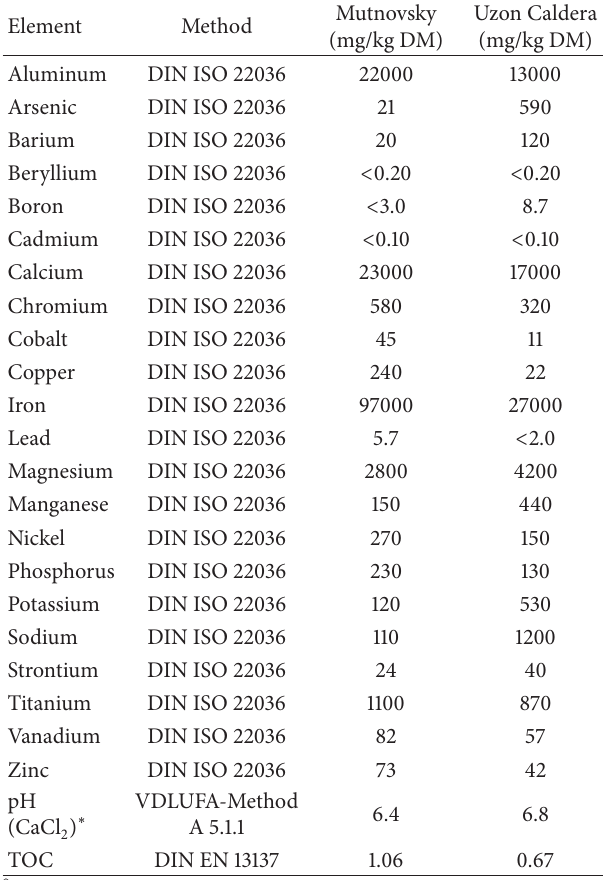
Table 1: Chemical analysis of the two investigated sediment samples (DM: dry matter, DIN: in accordance with the DIN (German Insti- tute for Standardization) norm, VDLUFA: Association of German Agricultural Analytic and Research